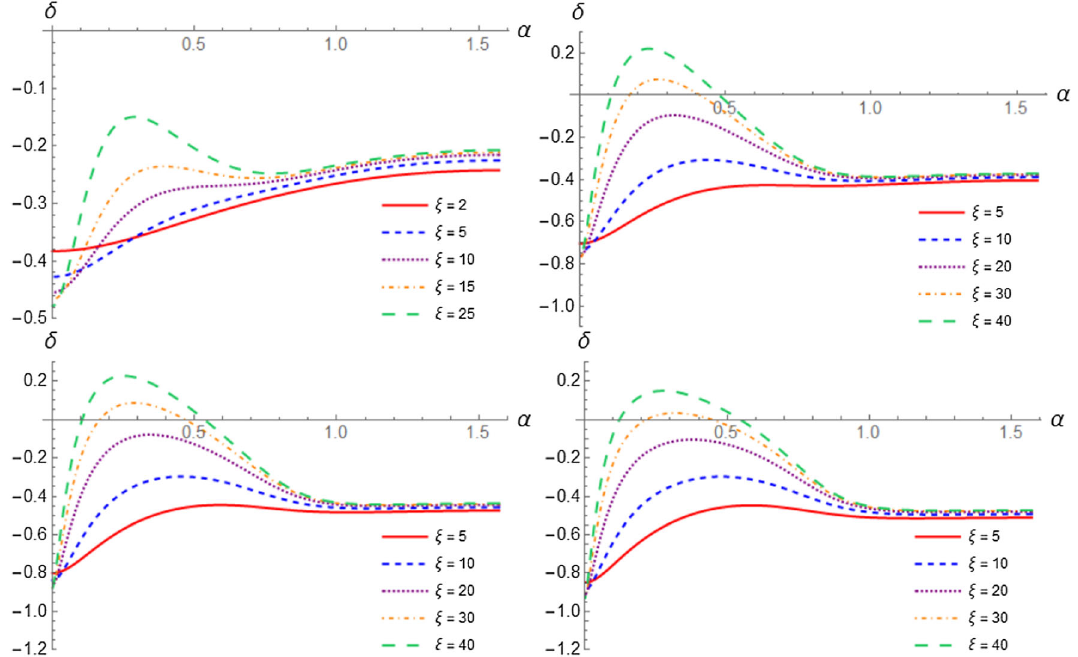
Fig. 10 Plots of the relative change of the absolute value of velocity δ αα (cid:2) (ξ) < 0 as a function of the incidence angle α for ξ = 2 (solid), ξ = 5 (dashed), ξ = 10 (dotted), ξ = 15 (dash-dotted) and ξ = 25 (long dash) for σ = 2 (top left), σ = 5 (top right), σ = 10 (bottom left) and σ = 20 (bottom right)